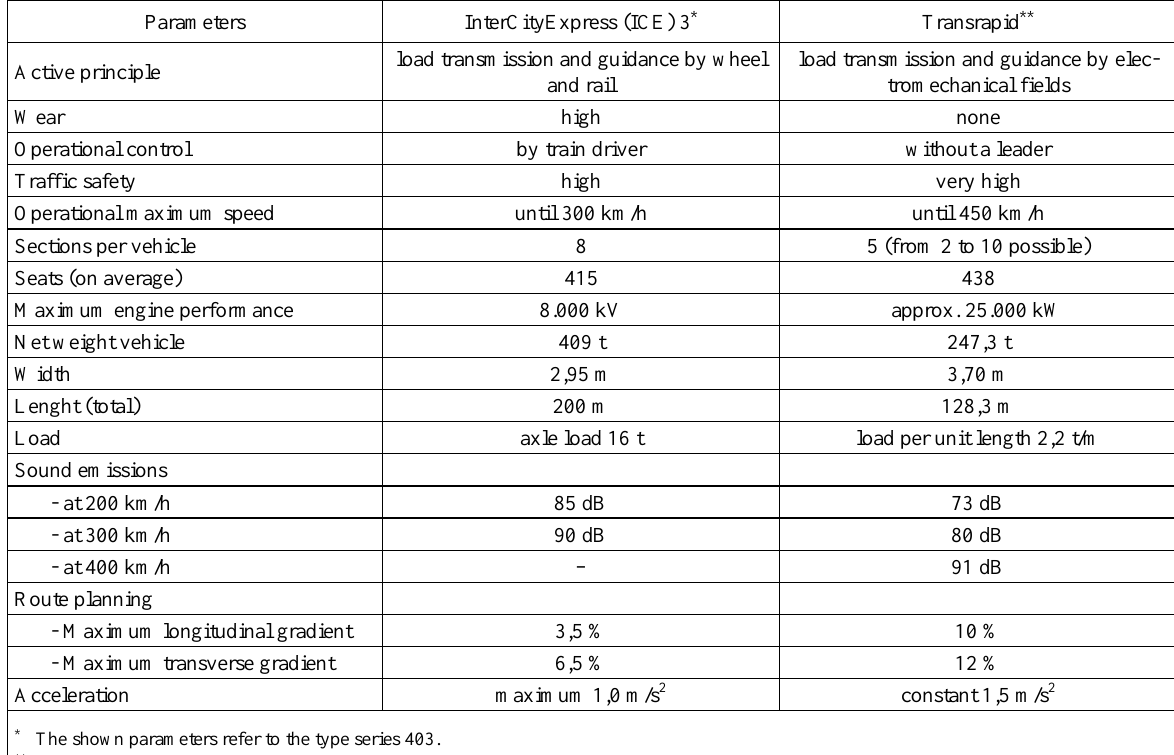
Table 1. Comparison between technical parameters of the ICE and the Transrapid